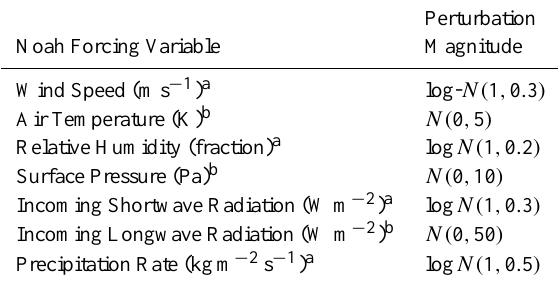
Table 2. List of meteorological forcing variables applied to the Noah model and perturbed during ensemble data assimilation to- gether with the nature of the perturbation applied to them. The perturbation distribution was either log-normal (i.e., multiplying the reference variable) or normal (i.e., adding to or subtracting from a reference value). The magnitude of perturbations used in the DART framework is based on a literature review of several studies including Zhou et al. (2006), Zhang et al. (2010), Reichle et al. (2002, 2007, 2008), Walker and Houser (2004), Sabater et al. (2007), Kumar et al. (2012), Dunne and Entekhabi (2005), Mar- gulis et al. (2002), Reichle and Koster